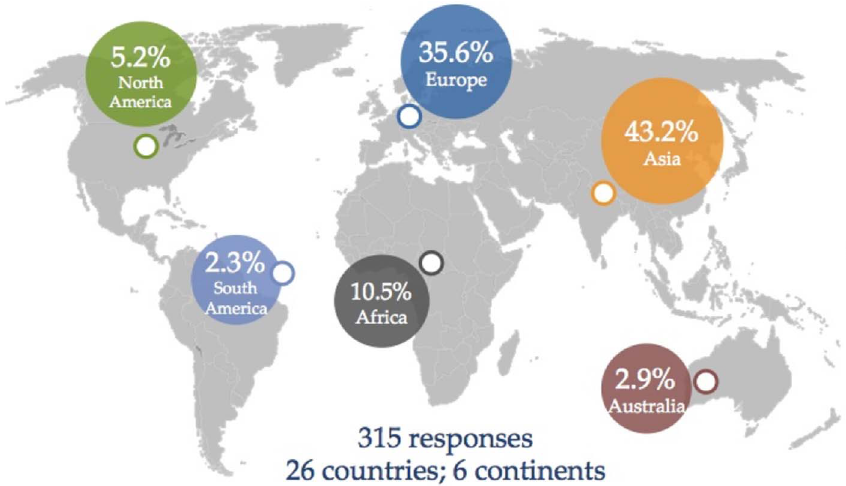
Figure 1. Survey participants by continent.